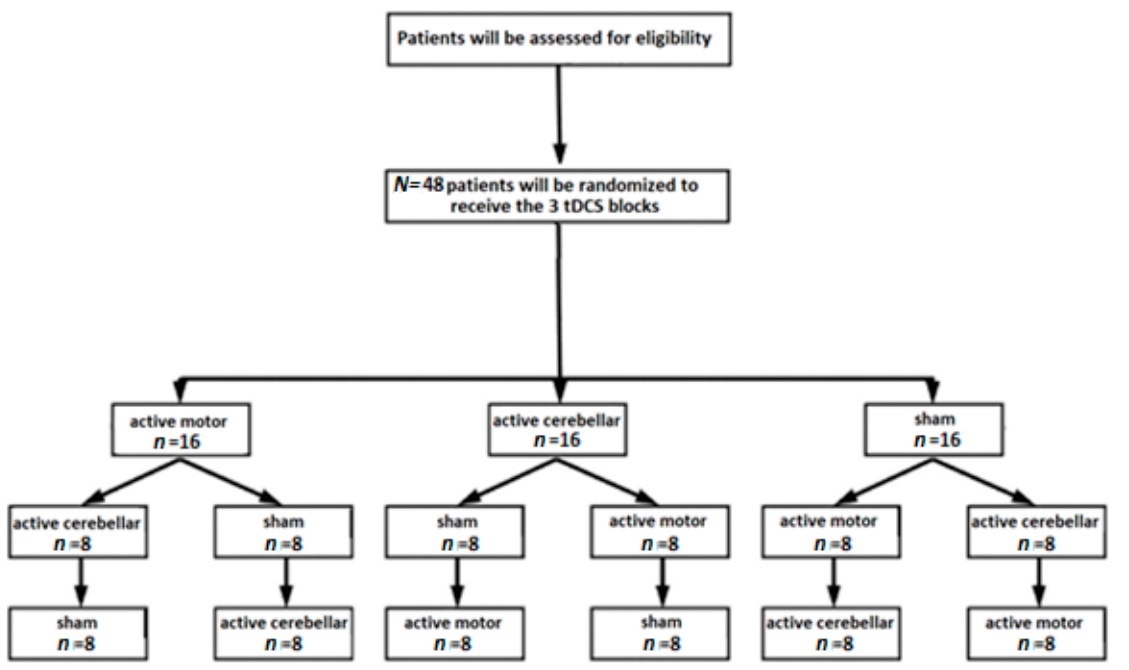
Figure 2. Flow chart of the study protocol.